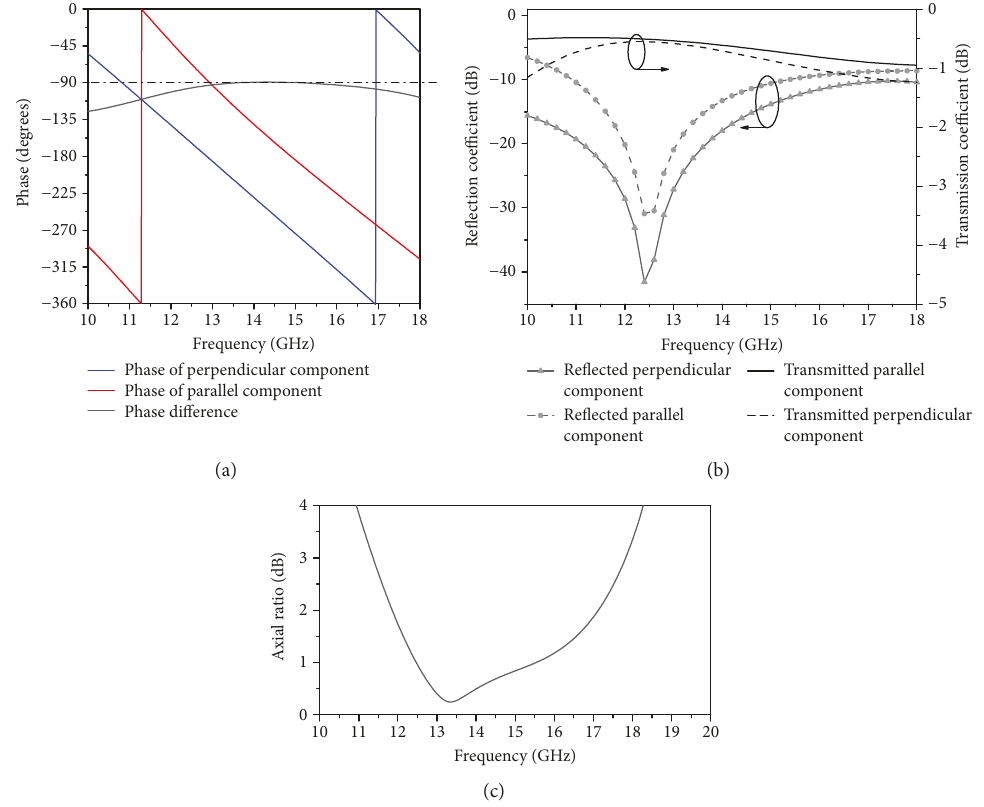
Figure 3: The simulation results of the proposed FSS structure. (a) The phase relation between output wave in perpendicular and parallel direction. (b) The transmission and re fl ection coe ffi cients. (c) The axial ratio of proposed FSS under normal incidence.